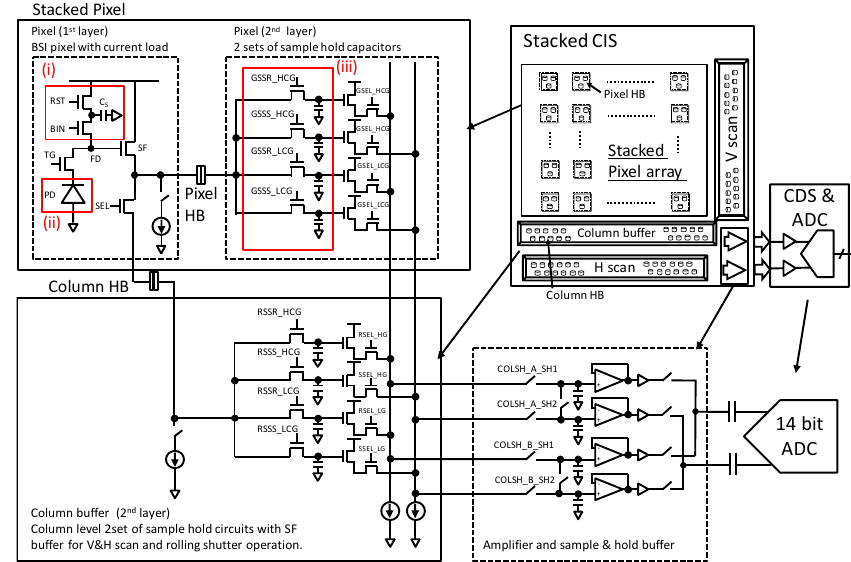
Figure 2. Schematic diagram and an off-chip signal processing block.